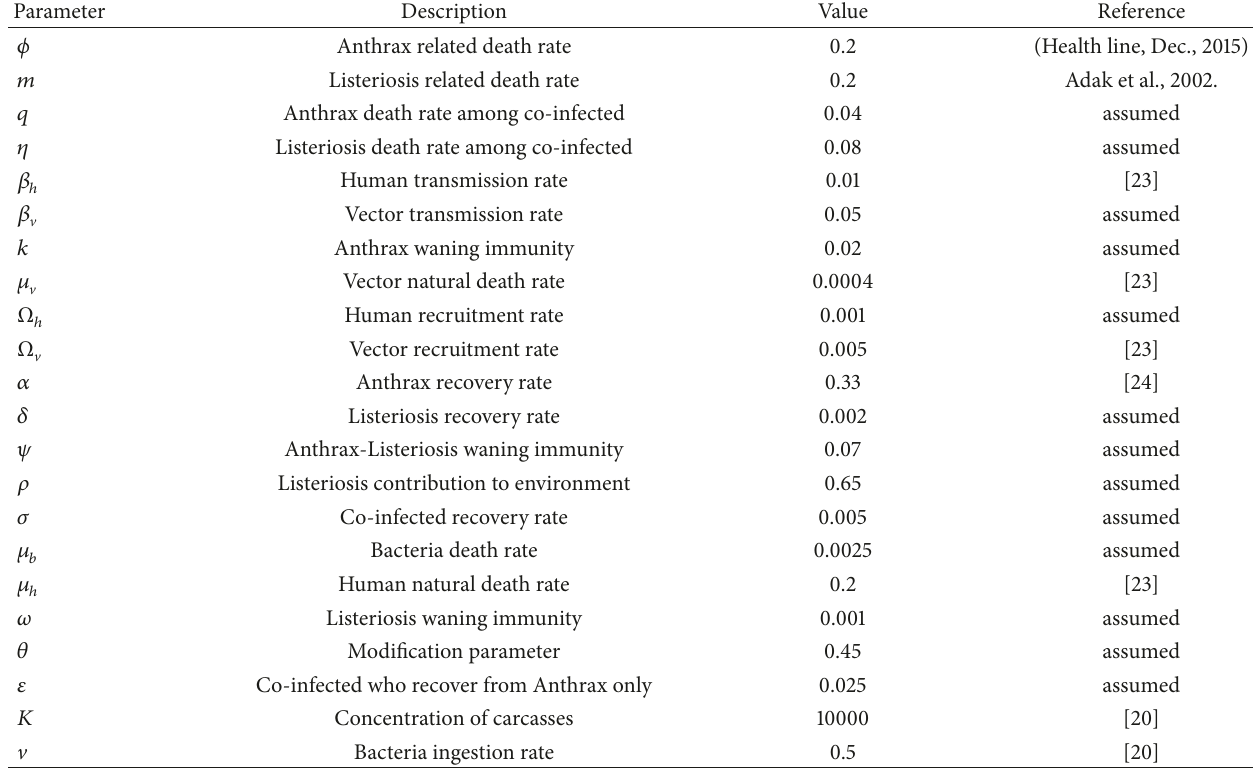
Table 3: Variable and parameter values of the coinfection